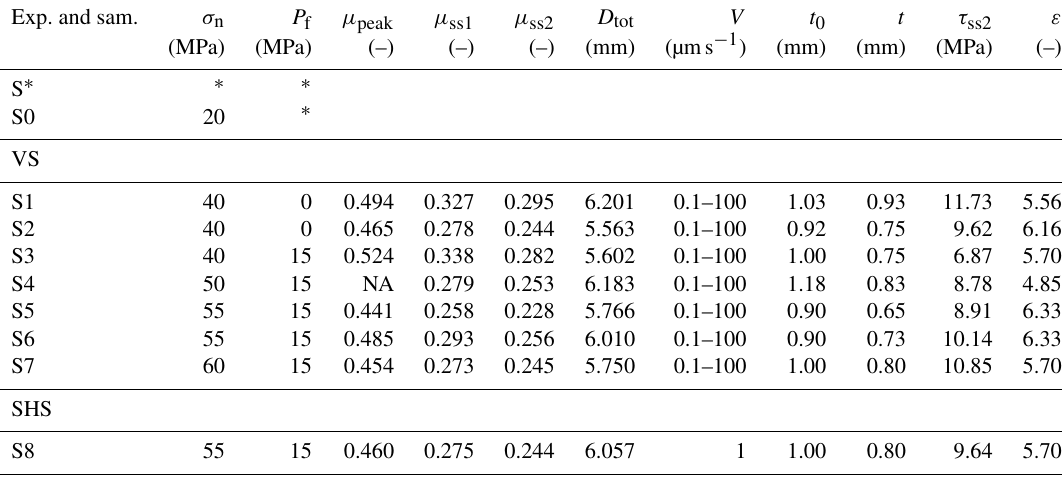
Table 1. List of experiments, experimental conditions and key mechanical data. VS: velocity stepping, SHS: slide–hold–slide. Note that all experiments reported here were performed at ∼ 100 ◦ C. σ n and P f represent the confining pressures and pore fluid pressure employed in the experiments. µ peak represents the peak friction coefficient obtained at 0.5–0.75mm of shear displacement, and µ ss1 and µ ss2 represent the near-steady-state friction coefficient obtained at ∼ 2 . 2 and ∼ 5 . 7mm of shear displacement, respectively. D tot represents the total shear displacement. t 0 and t represent the thickness of the gouge layer measured before and after the experiments, respectively. τ ss2 and ε represent the steady-state shear stress and shear strain measured at the shear displacement of ∼ 5 . 7mm, and the latter is defined as engineering shear strain, i.e., ε = d/t 0 , where d is the shear displacement. Here, ε equals 5.7 divided by initial thickness t 0 . Exp. and